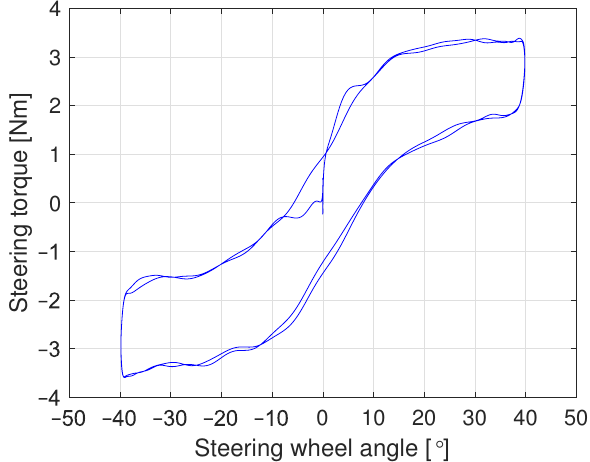
Figure 1. Typical on-center response, exhibiting the software developed non-linear relation between the steering wheel angle and the steering torque.